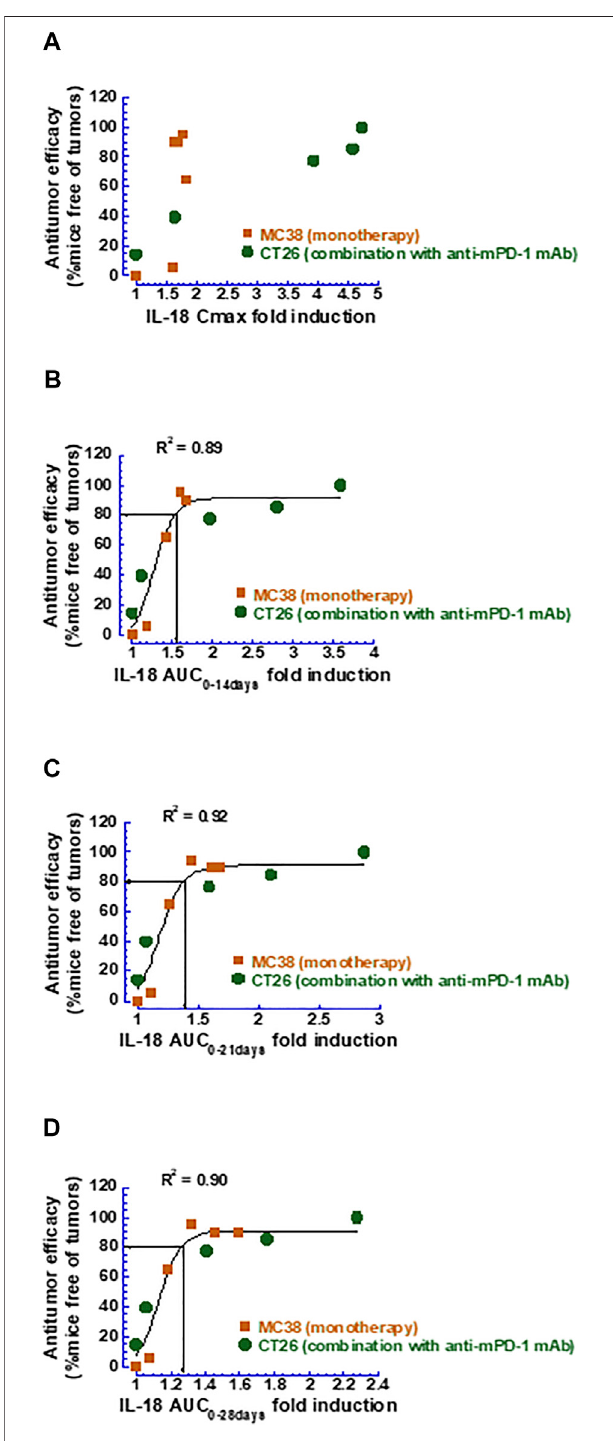
FIGURE 4 | Correlation between various metrics of mouse IL-18 fold- induction and antitumor ef fi cacy measured as the percentage of mice that weretumor-free. (A) MouseIL-18fold-inductionbasedonC max ; (B) MouseIL- 18fold-inductionbasedonAUC 0 – 14 days ; (C) MouseIL-18fold-induction based on AUC 0 – 21 days ; (D) Mouse IL-18 fold-induction based on AUC 0 – 28 days